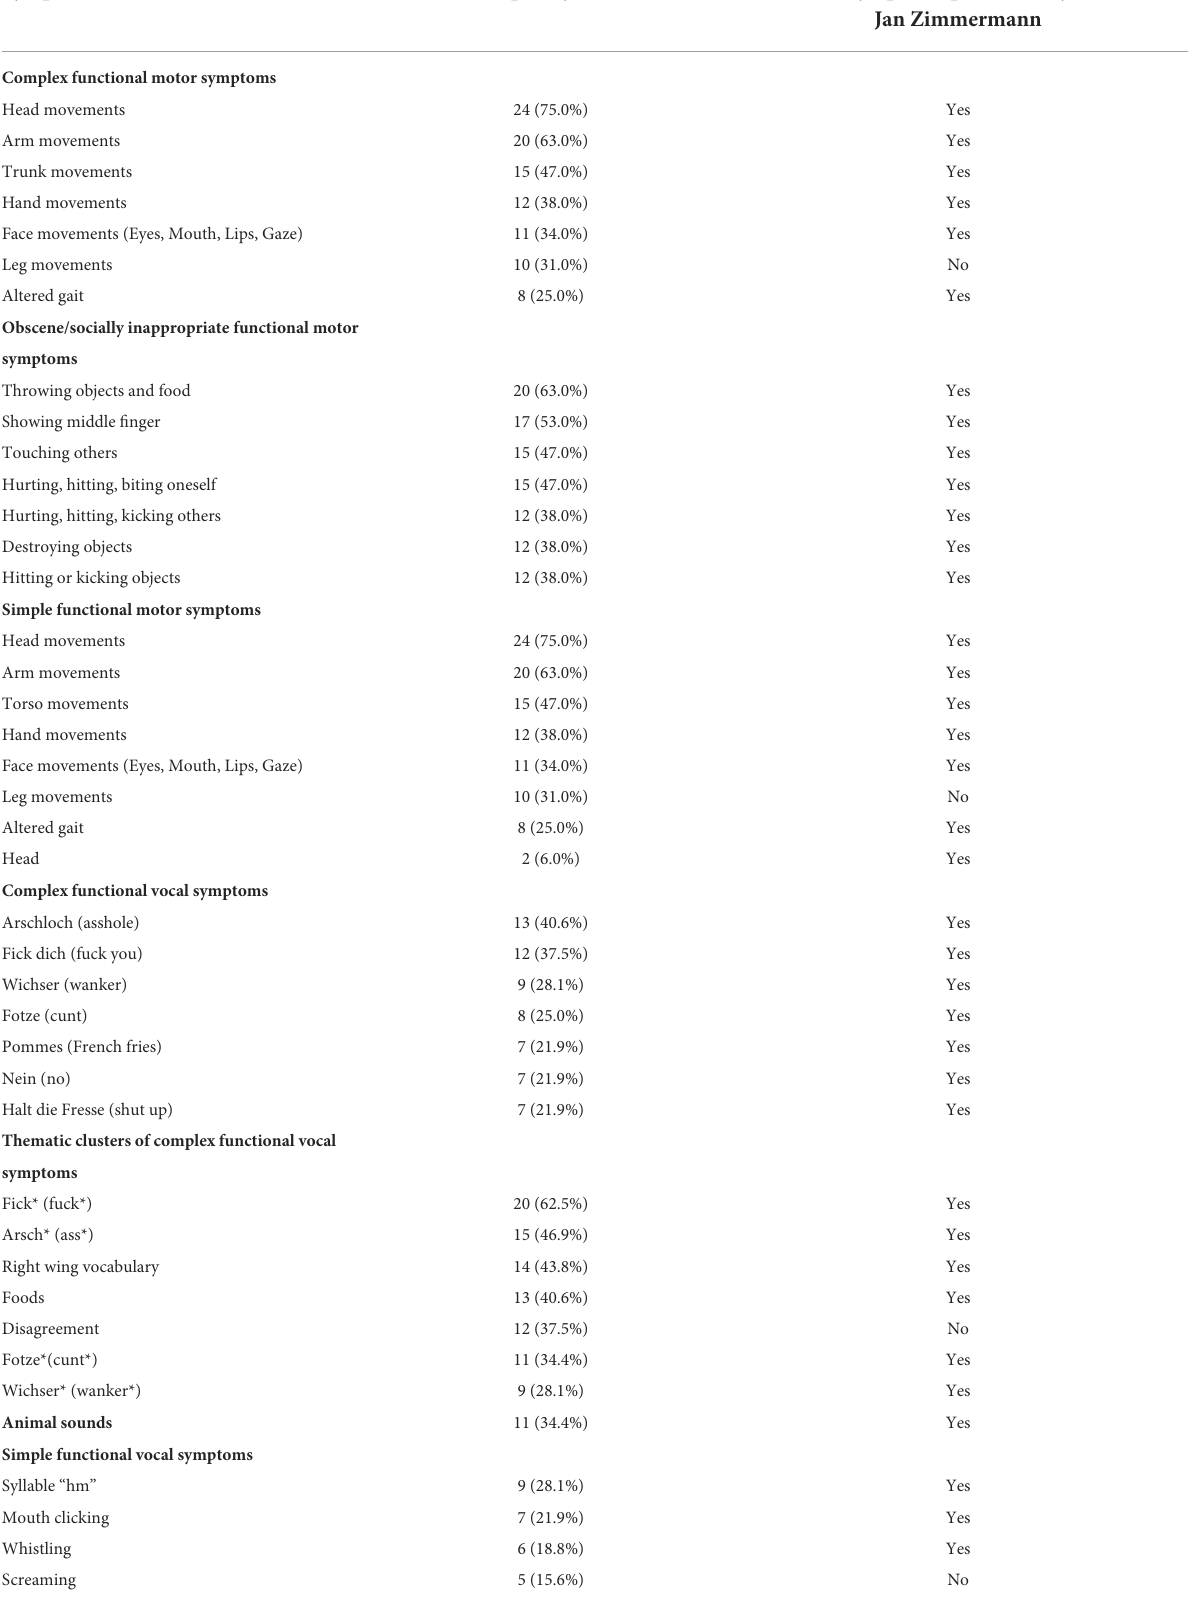
TABLE 2 Most common functional motor and vocal symptoms: Type, localization, kind, frequency, and overlap with Jan Zimmermann’s symptoms ( n = 32). Symptom Frequency n (%) Symptoms presented by